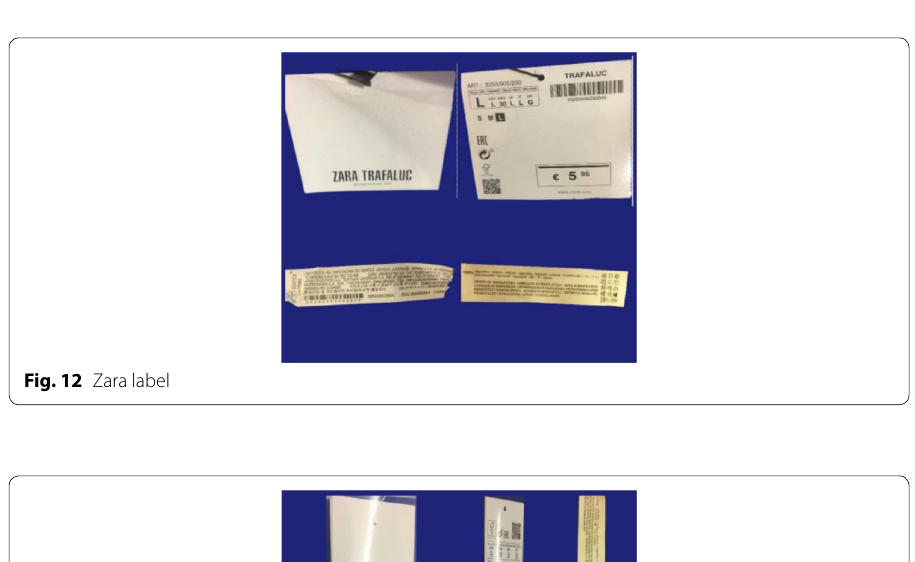
Fig. 11 Stradivarius label